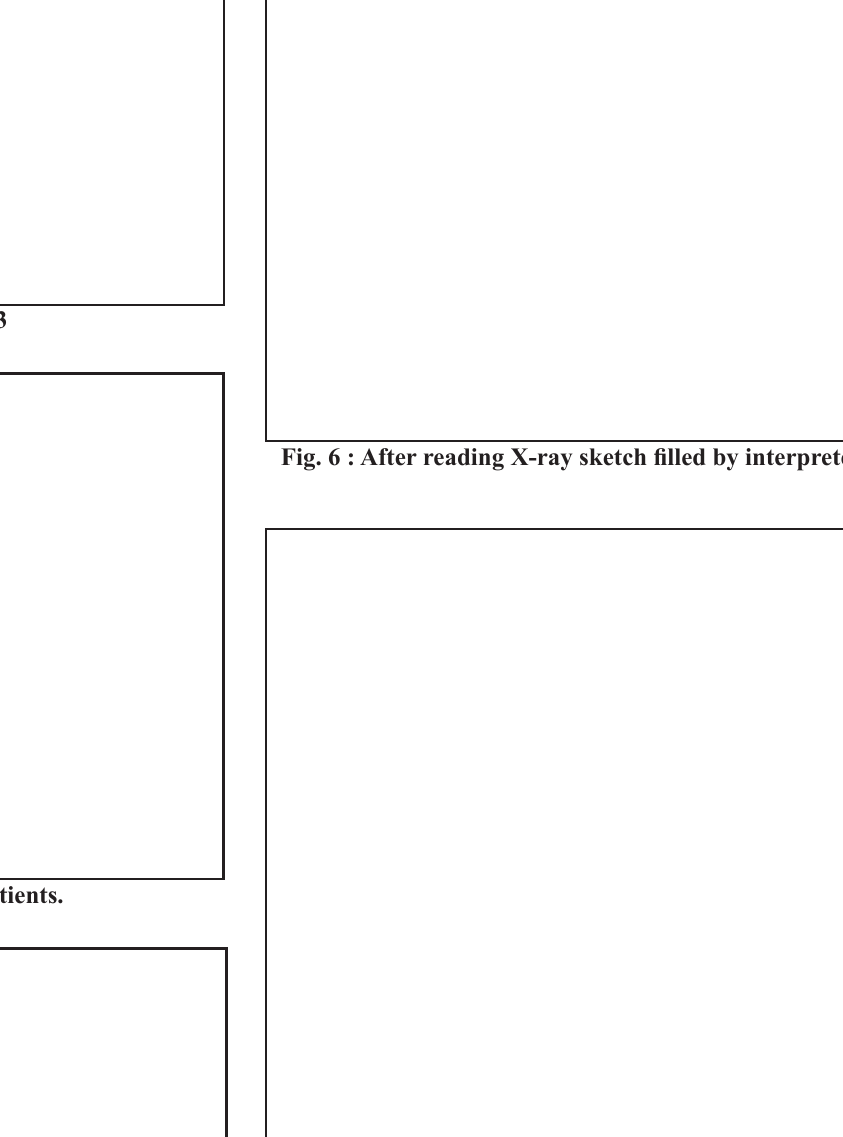
Fig. 7 : Diagnosis of individual X-rays written by indi- vidual